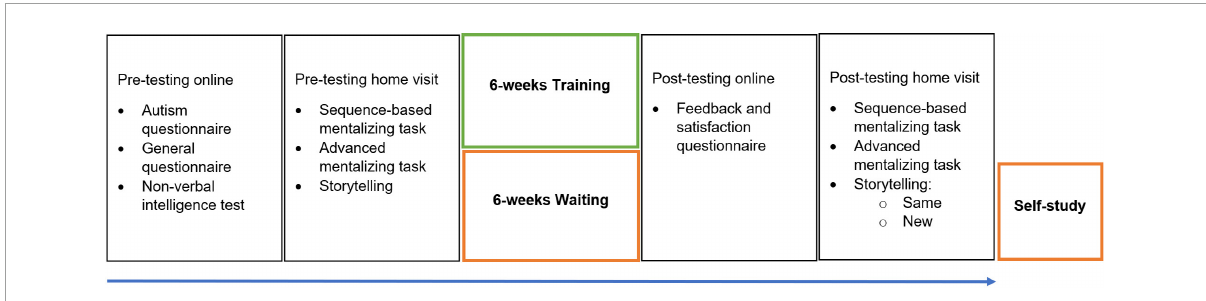
FIGURE1 Study Procedure. Pre-testing consisted of online questionnaires and intelligence test, and a home-visit. Participants in the Training group immediately started their 6-week training after pre-testing while participants in the Control group waited. Post-testing consisted of an online feedback questionnaire and a home visit. Participants in the Control group received a self-study bundle of the training.